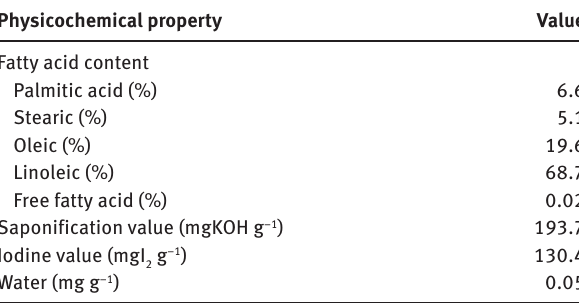
Table 1: The physicochemical properties of sunflower